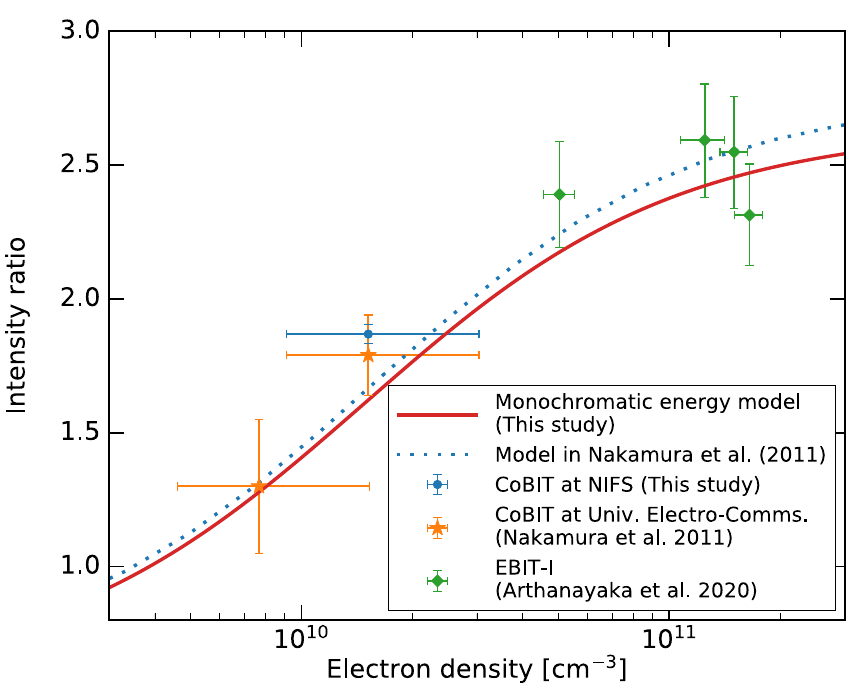
Figure 8. Electron density dependence of Fe XIV 264 Å/274 Å intensity ratio from EBIT experimental data. Blue-filled circle is measurement with CoBIT-II at NIFS. Orange-filled stars are measurements with CoBIT-I at University of Electro-Communications [15]. Green-filled circles are measurements with EBIT-I at Lawrence Livermore National Laboratory [16]. Red line represents model calculations of monochromatic energy using same atomic data as in our CR-model for thermal plasma. Blue dotted line denotes model results of Reference